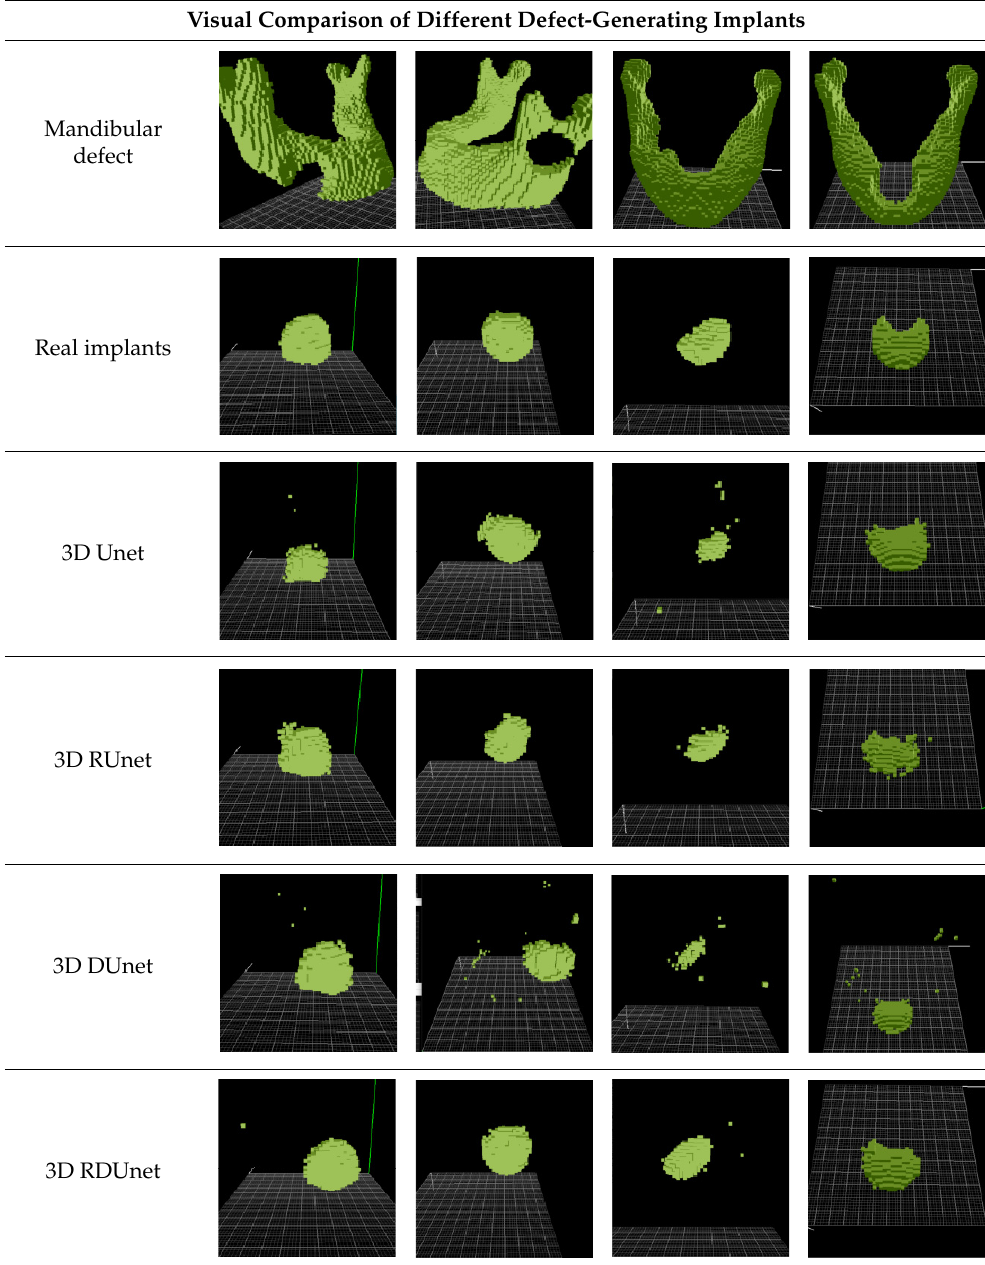
Table 4. Visual comparison of di ff erent defect-generating implants.